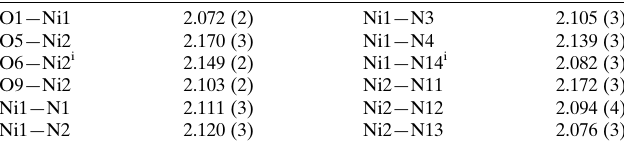
Table 1 Selected bond lengths (A˚